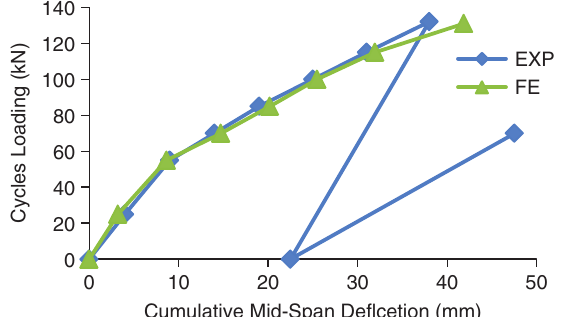
Fig. 13. Load against cumulative mid-span de fl ection for the post-repair phase of the beam G2R1